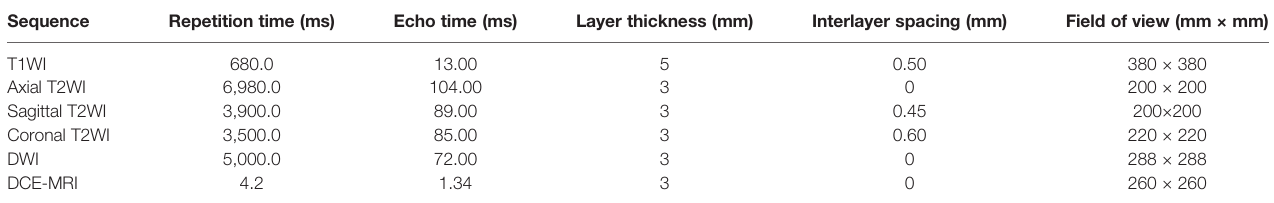
TABLE 1 | Multi-parameter MRI scan sequence and parameters.